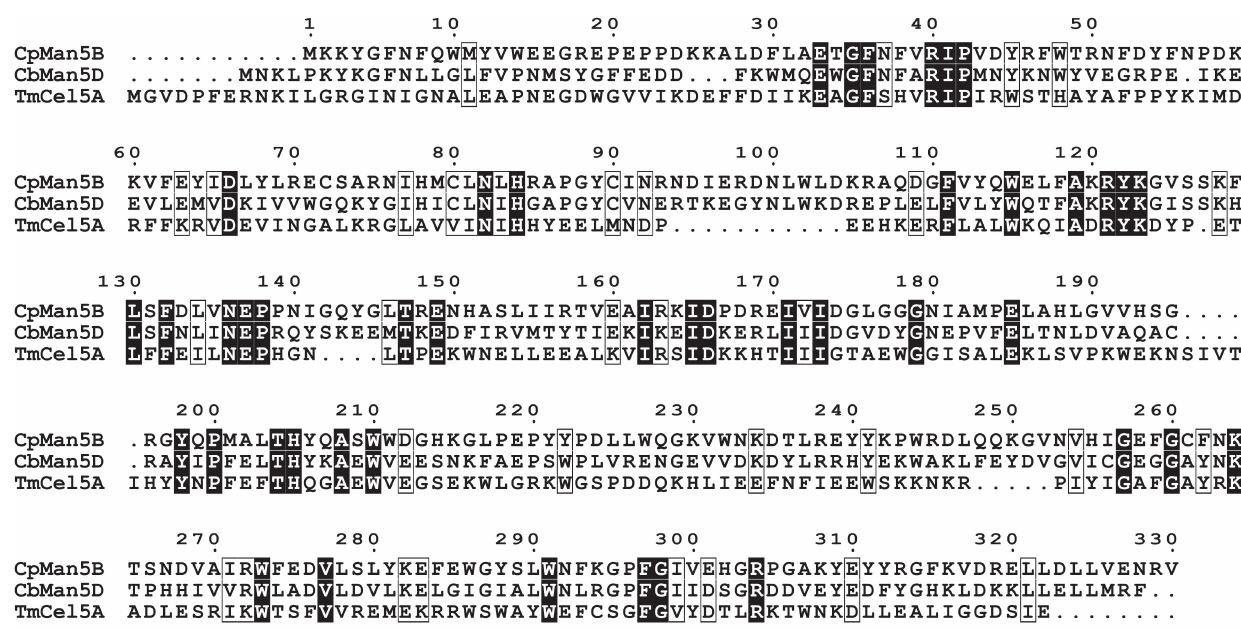
Figure 5. Amino acid sequence alignment of CpMan5B, CbMan5D, and TmCel5A. The three polypeptides were aligned using ClustalW with the Blosum62 similarity matrix (http://www.genome.jp/tools/clustalw/). Boxes indicate similar residues and dark shading indicates identical residues. The GenBank accession numbers for CpMan5B, CbMan5D, and TmCel5A are ADK22147, ACM59384, and AAD36816,